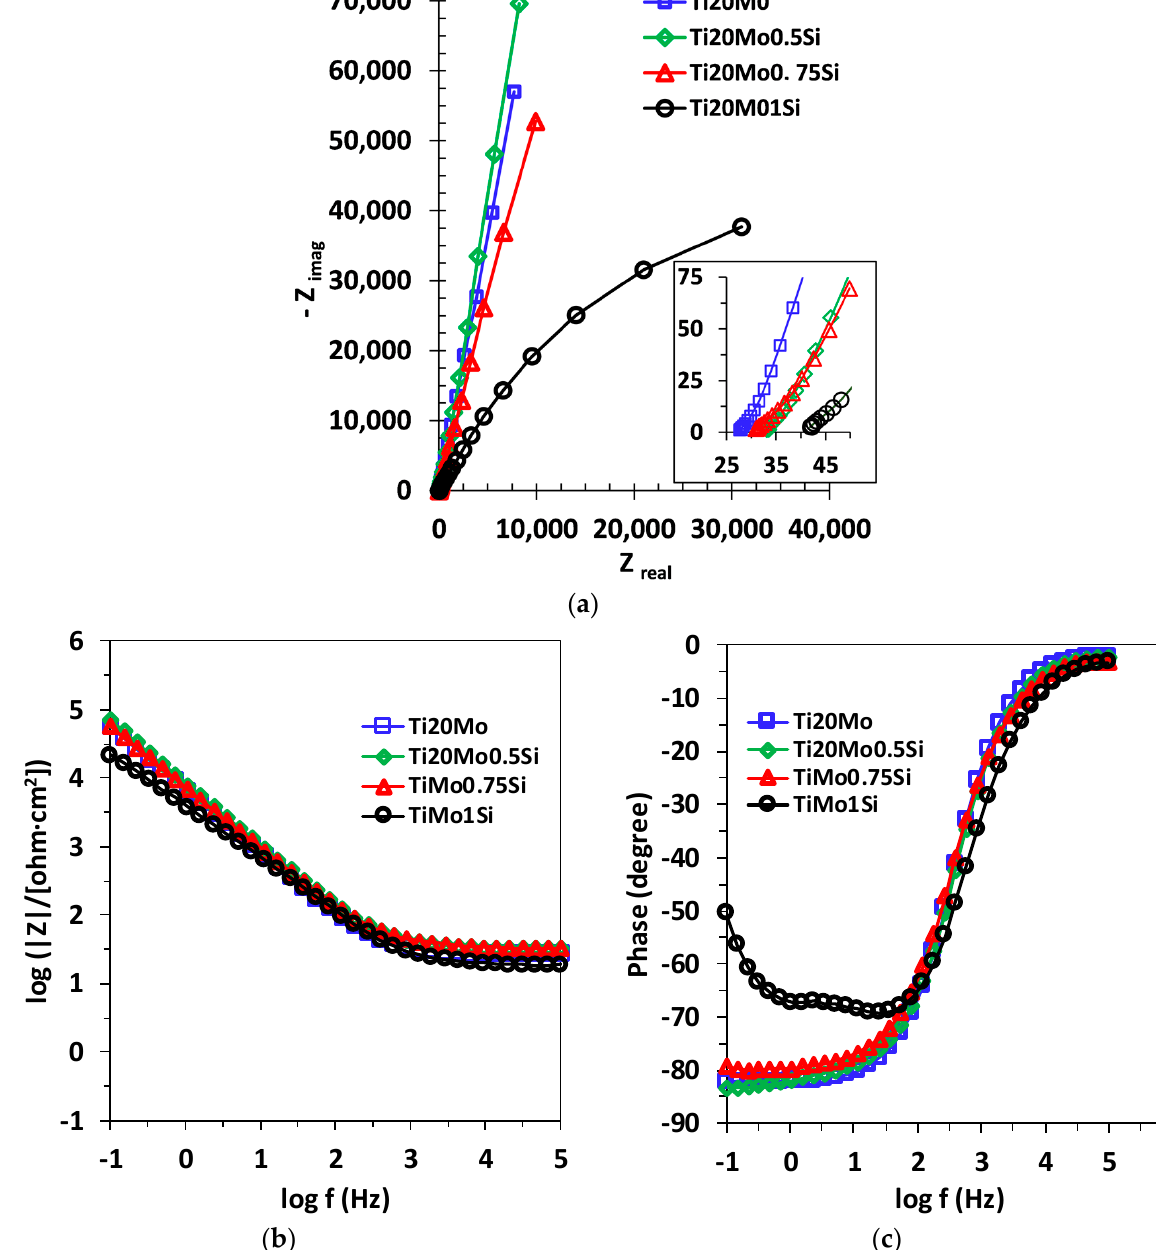
Figure 5. ( a ) Nyquist,( b ) Bode—IZI and ( c ) Bode—phase diagrams for Ti20Mo, Ti20Mo0.5Si, Ti20Mo0.75Si and Ti20Mo1.0Si alloys in Ringer’s